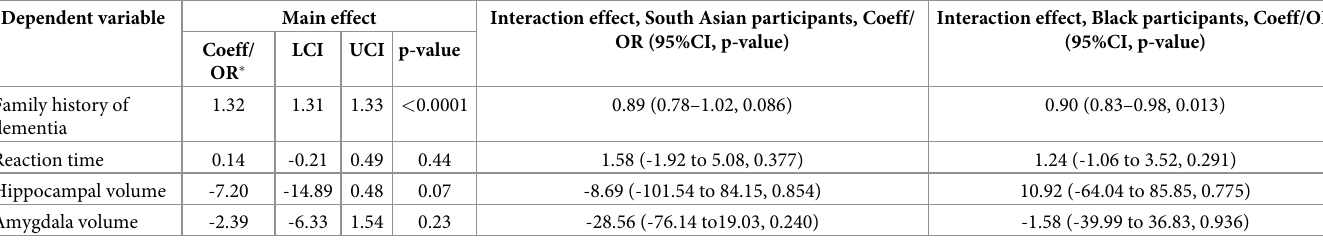
Table 3. Regression analyses for secondary outcomes with z-GRS including APOE as